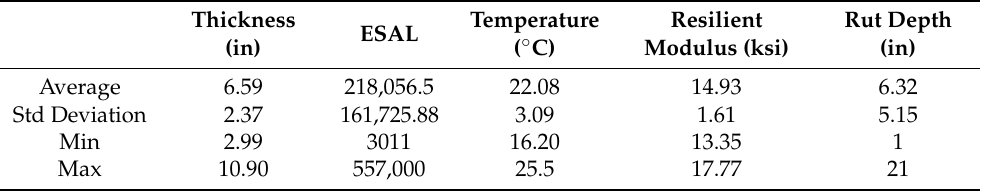
Table 3. Maximum, Minimum, and Average values for all input and output variables.